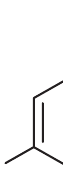
Figure 1: The chemical drawings for the H this study.